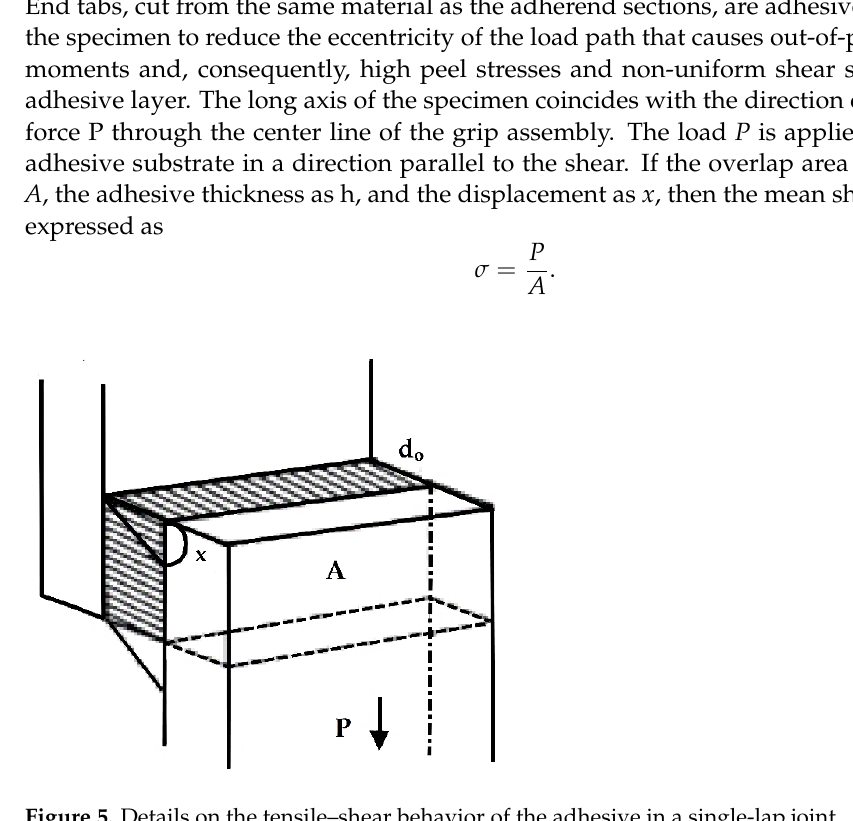
Figure 5. Details on the tensile – shear behavior of the adhesive in a single-lap joint.